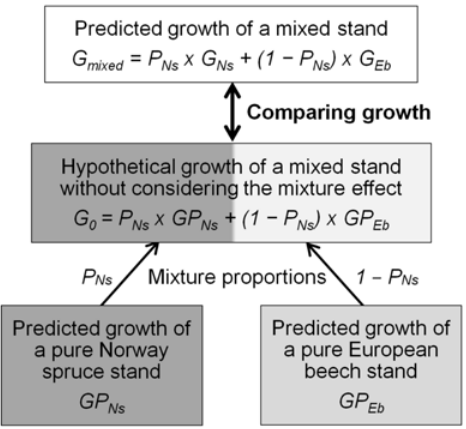
Figure 1. Comparing the productivity of pure and mixed stands. G mixed , the predicted growth of a mixed stand and G 0 , the predicted growth of a mixed stand under the null hypothesis (i.e., considering that no mixing effects occur).